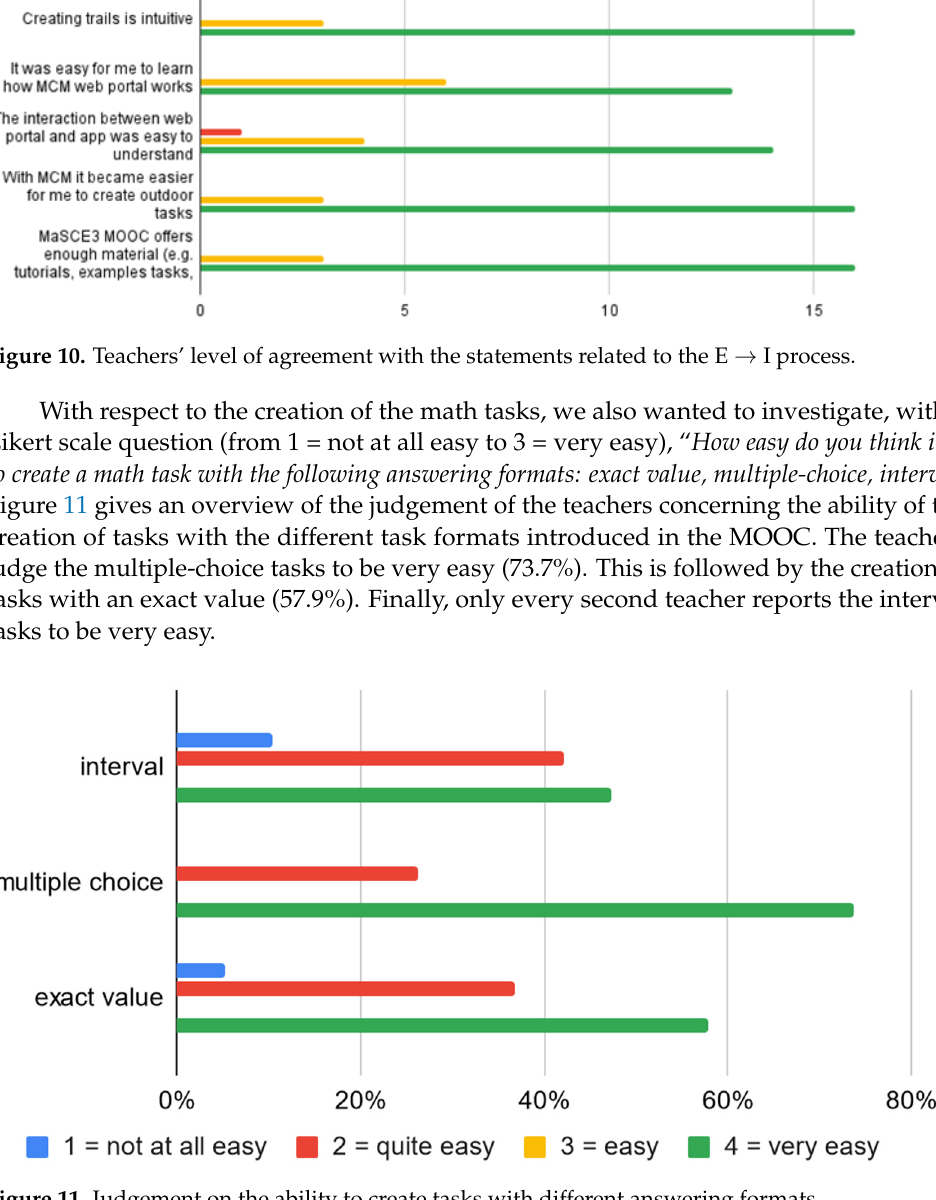
Figure 11. Judgement on the ability to create tasks with different answering formats.